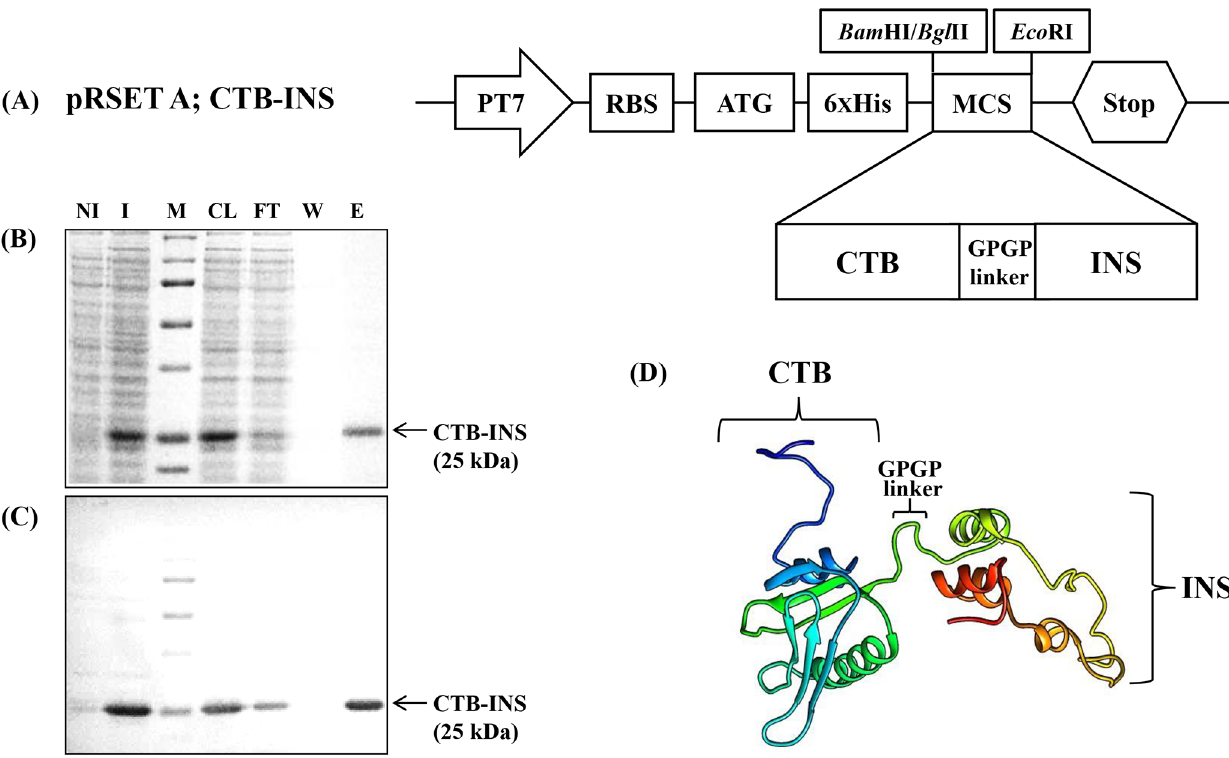
Fig 1. CTB-INS fusion protein was expressed from the E.co li pRSET A expression vector and purified using Ni-NTA agarose with the indicated imidazole concentration in the wash and elution steps. Panel (A) is a plasmid map of the E . coli expression vector pRSET A (Invitrogen, Carlsbad, CA), carrying the CTB-INS fusion gene. Panel (B) show the SDS-PAGE. Proteins were visualized by Coomassie staining. Lane NI: non-induced E . coli (BL21) cell; I: induced E. coli cell; M: protein size marker; CL: cell lysate; FT: flow-through; W: wash; E: elution. Panel (C) Western blot detection of recombinant CTB-INS fusion protein identified with anti-CTB primary antibody. The arrow indicates the purified CTB-INS proteins. Panel (D) shows the predicted CTB-INS protein structure using its protein sequence generated by the RaptorX